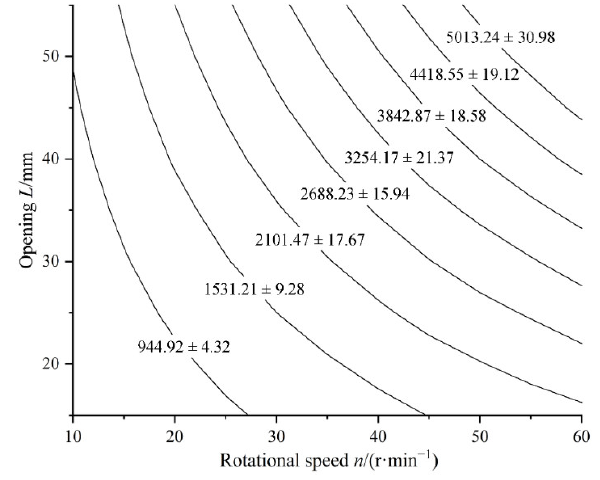
Figure 2. Contour curve between fertilizer amount and different speeds and openings. From Figure 2, it can be seen that the same target fertilizer amount can correspond to numerous combinations of rotational speeds and